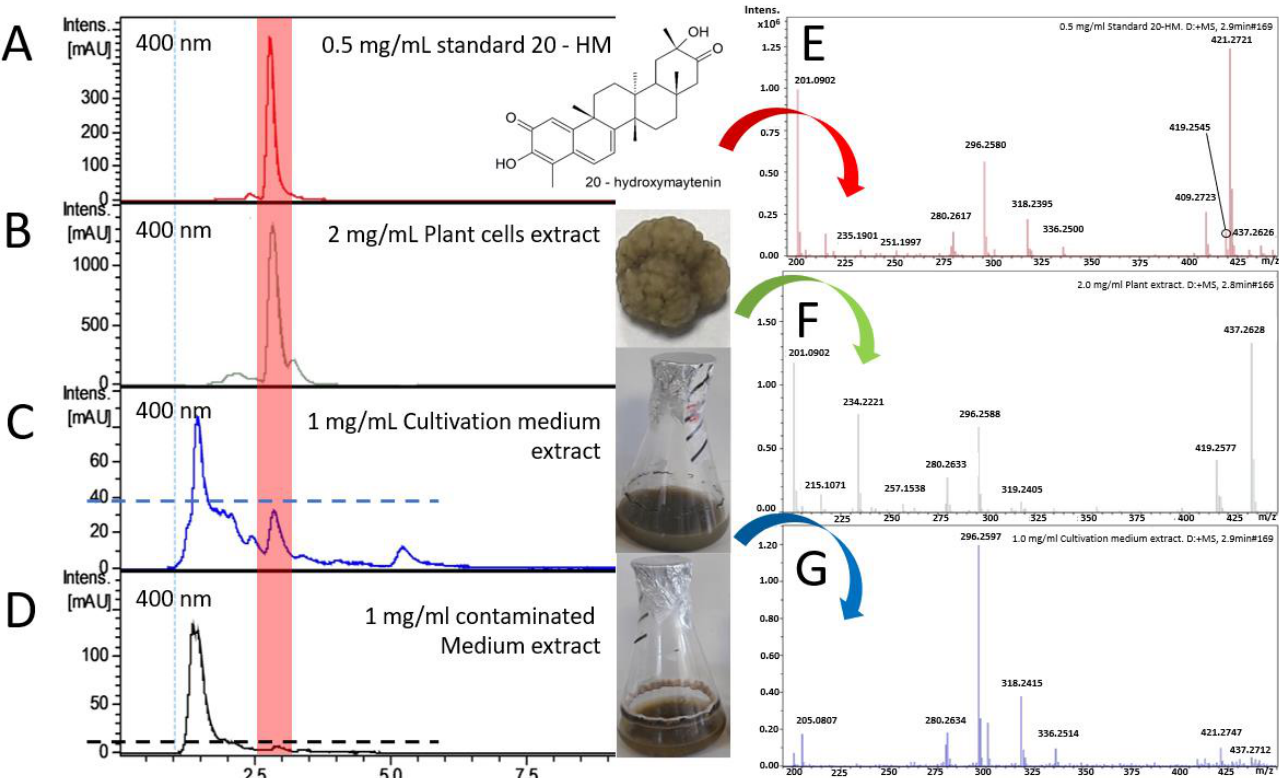
Figure 5. HPLC chromatograms and MS spectra of 0.5 mg/mL the standard 20-HM ( A and E ); 2 mg/mL G. heterophylla cells extract ( B and F ); 1 mg/mL cultivation medium extract ( C and G ); and 1 mg/mL infected medium ( D ). The highlighted red box indicates similar Rt values (2.8 to 2.9 min) between samples and the standard 20-HM.